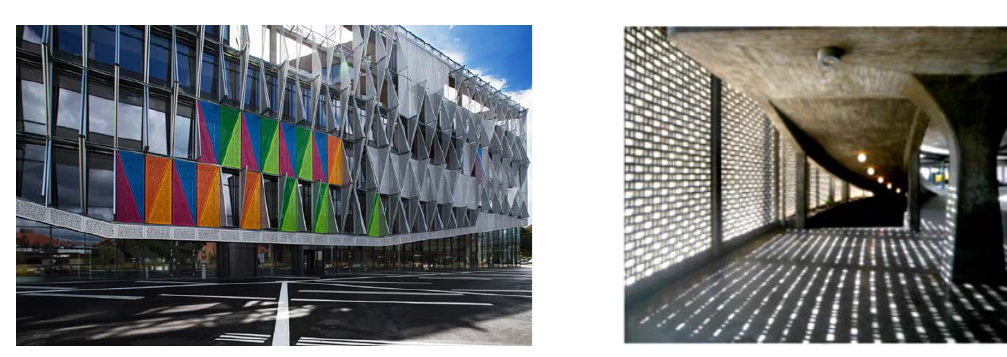
Fig 3 Folding Screen System(city-emotion.com) Fig 4 Simple Double Skin Metal